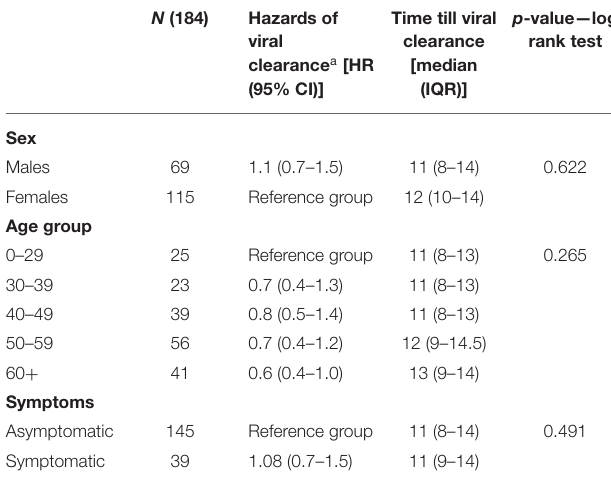
TABLE 2 | Median time till viral